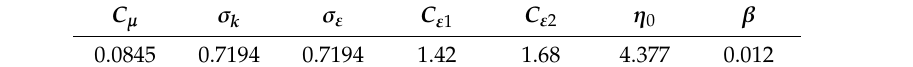
Table 1. Constants used in the Re-Normalization Group (RNG) k- ε model.